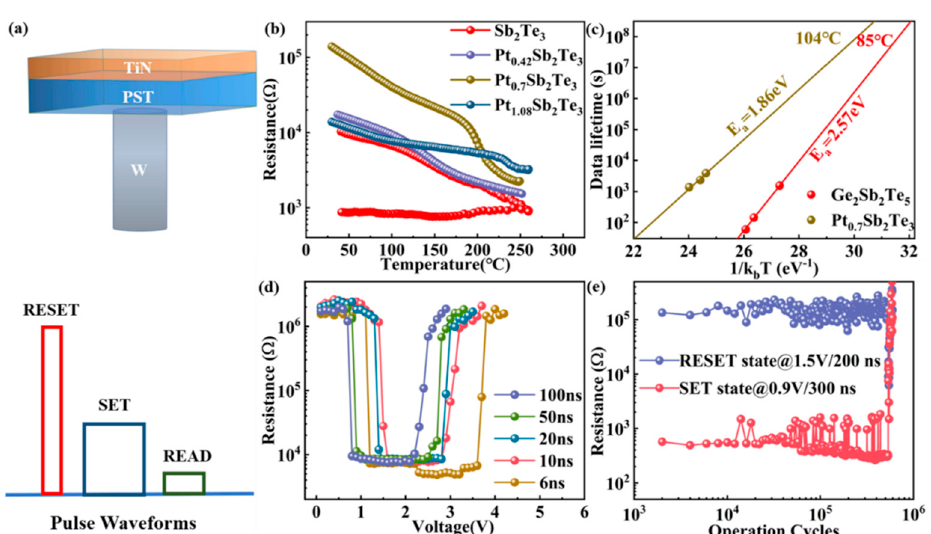
Figure 1. Device performance. ( a ) The schematic diagram of the T − shaped phase change memory (PCM) device. Schematic diagram of three pulse voltages of RESET, SET, and READ of PCM. ( b ) The temperature dependence of the resistance of Sb 2 Te 3 , Pt 0.1 Sb 2 Te 3 , Pt 0.14 Sb 2 Te 3 (PST), and Pt 0.22 Sb 2 Te 3 films at the same heating rate of 20 ◦ C/min. ( c ) At the heating rate of 60 ◦ C/min, the extrapolated fitting line based on the Arrhenius formula shows the 10 − year data retention temperature and crystallization activation energy. ( d ) Resistance − voltage characteristics of PST based T − shaped PCM device. The SET − RESET programming windows are obtained under different pulse widths. ( e ) Endurance characteristic of PST based PCM T − shaped